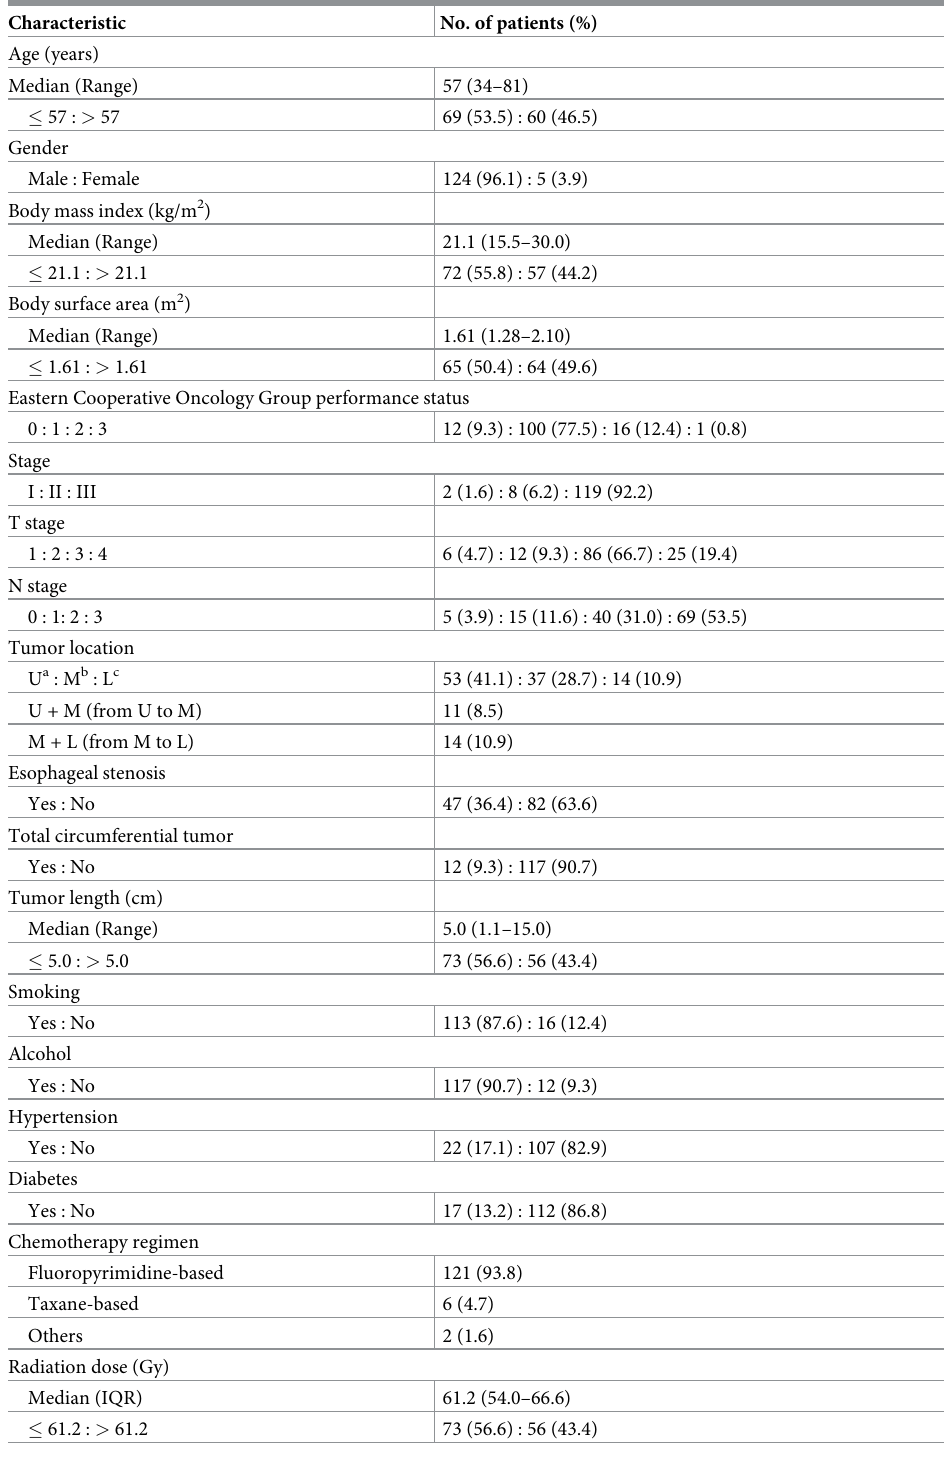
Table 1. Demographic and clinical characteristics of patients at